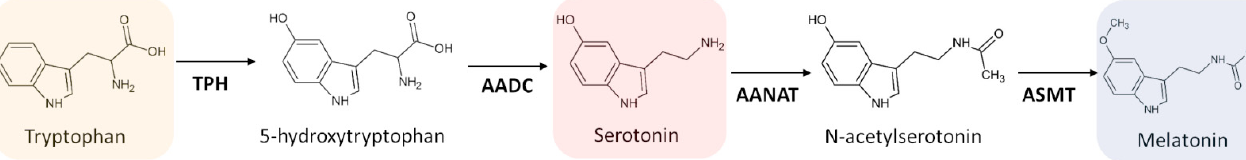
Figure 7. The classic melatonin synthetic pathway in animals. TPH: tryptophan hydroxylase; AADC: aromatic amino acid decarboxylase; AANAT: aralkylamine N-acetyltransferase; ASMTs: acetylserotonin O-methyltransferase.